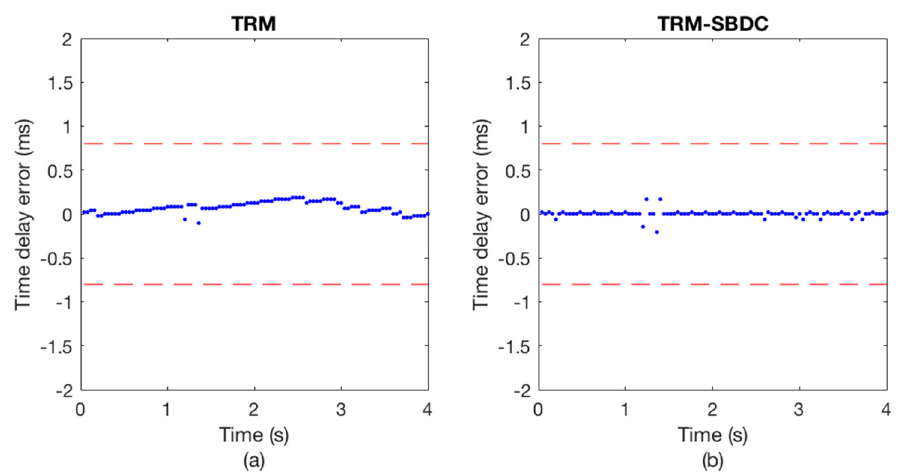
Figure 12. The decoding results of the corresponding data. ( a ) Without TRM; ( b ) with TRM.